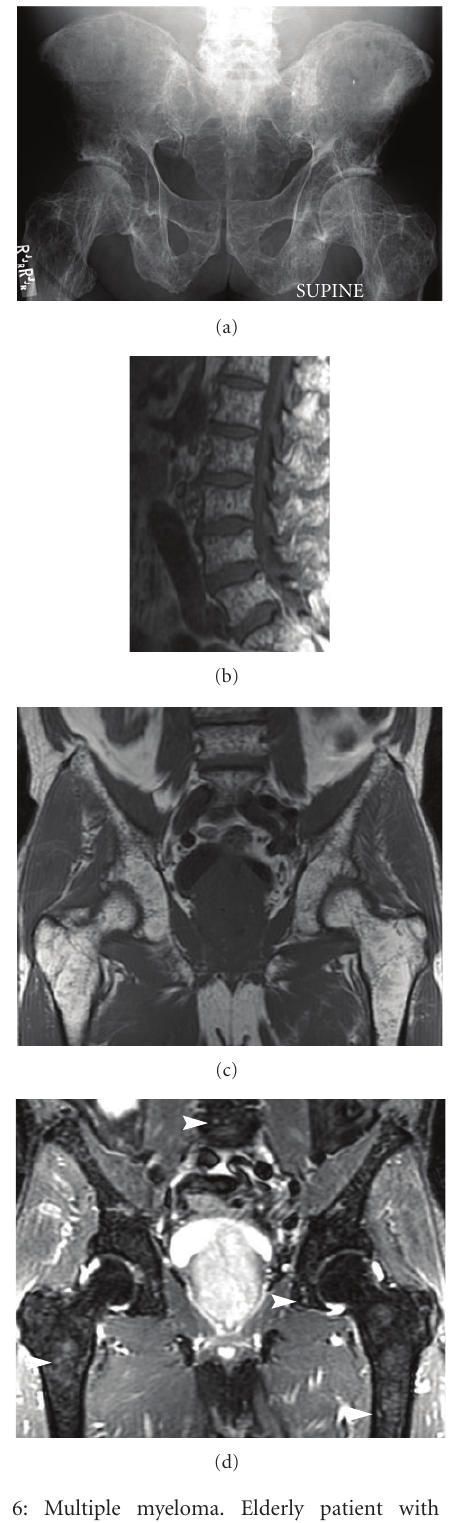
Figure 6: Multiple myeloma. Elderly patient with multiple myeloma. Plain film (a) demonstrates extensive osteopenia and multiple punched-out lytic lesions involving the entire pelvis. Sagit- tal T1 (b) of the lumbar spine, coronal T1 (c), and coronal STIR (d) demonstrate innumerable T1 hypointense and T2 hyperintense lesions (arrowheads) in the medullary cavity of the entire visualized